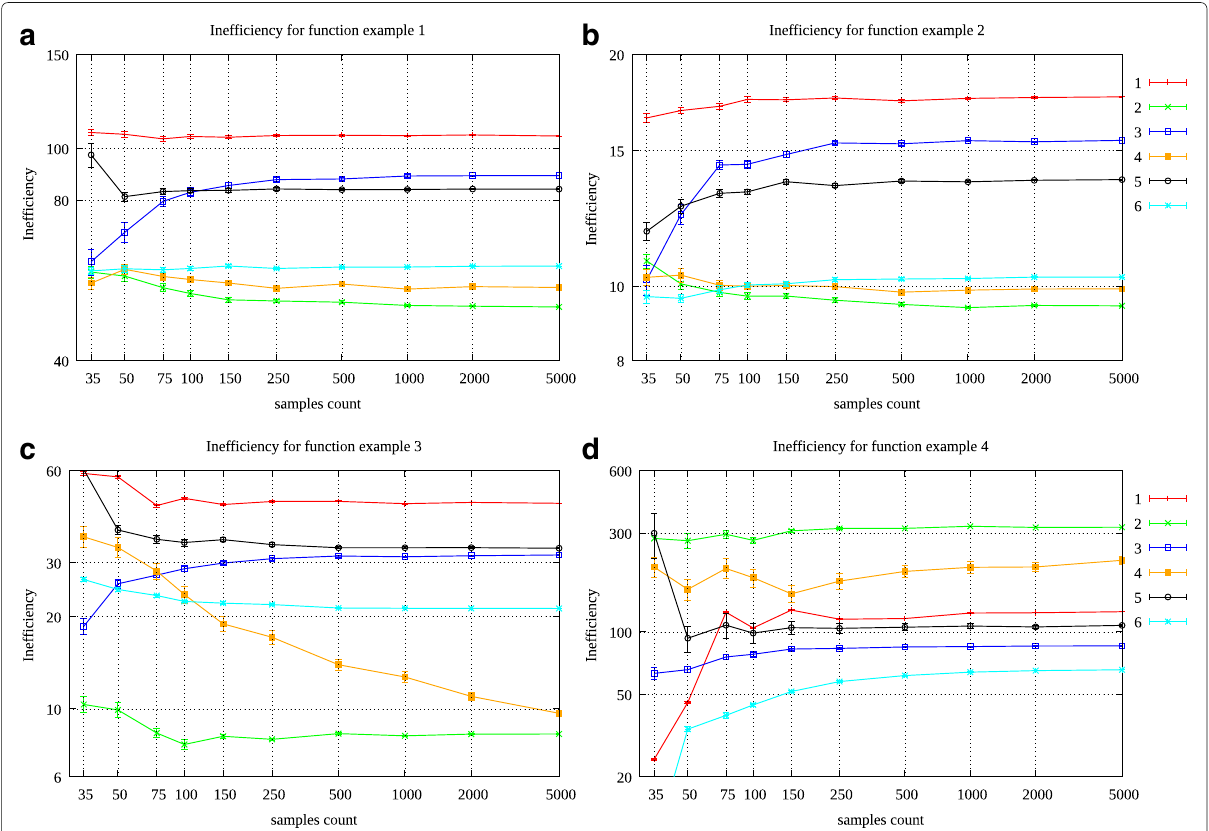
Fig. 3 The inefficiency for the estimators for adaptive sampling for different samples count and specific costs of sampling techniques for examples in Appendix C. a Example 1, b example 2, c example 3, and d example 4. Notation of lines 1 to 6 in charts follows the order of rows in Table